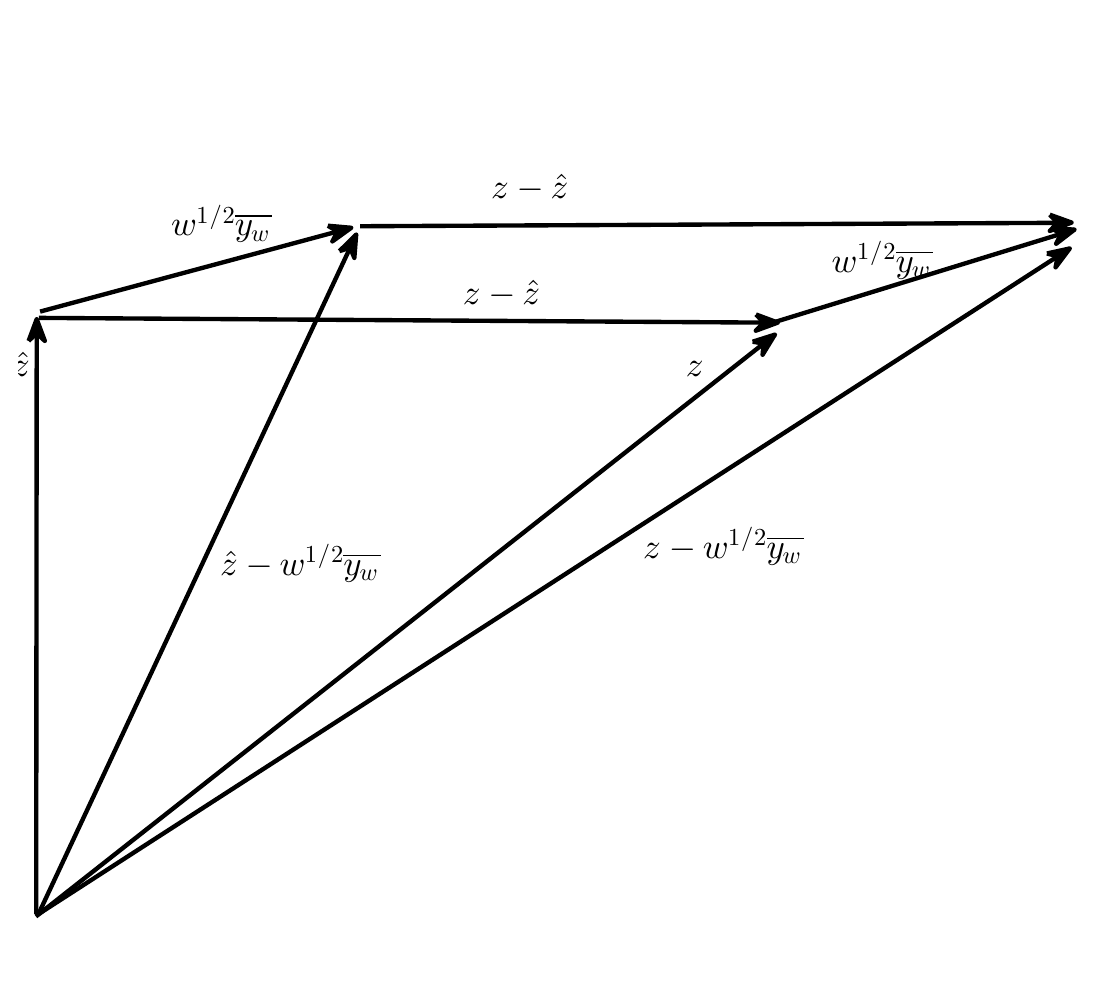
Figure 1: The residuals z − ˆ z are orthogonal to both the estimates ˆ z and the vector y w 1 2 w